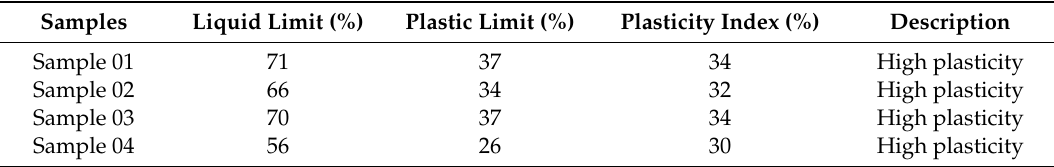
Table 2. Summary of Atterberg’s limits of soil